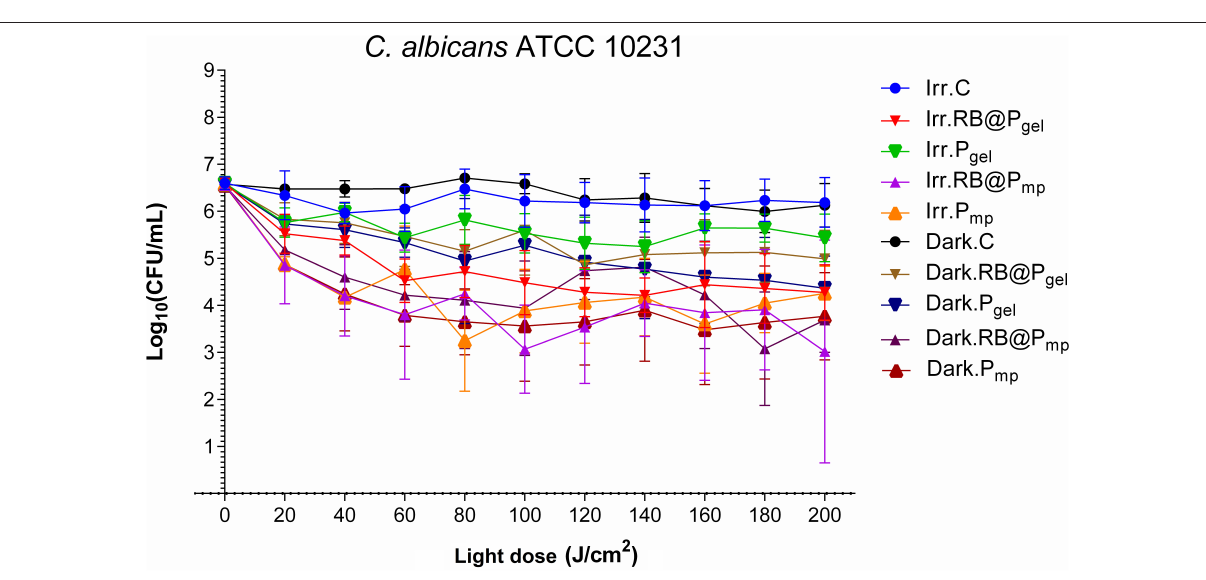
formation like extended incubations (24–72 h) are